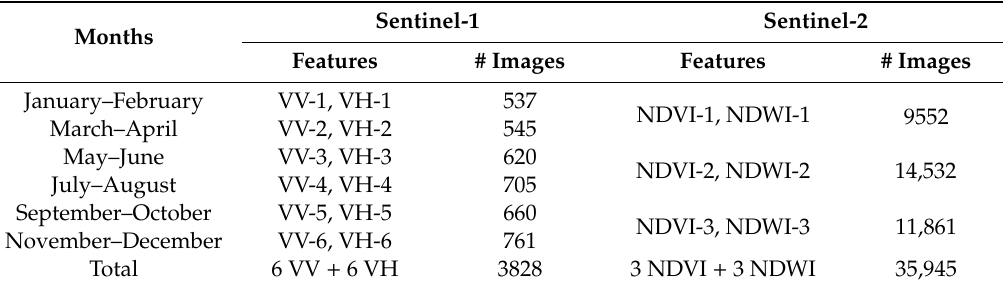
Table 2. Number of the Sentinel-1 and Sentinel-2 images used for each time